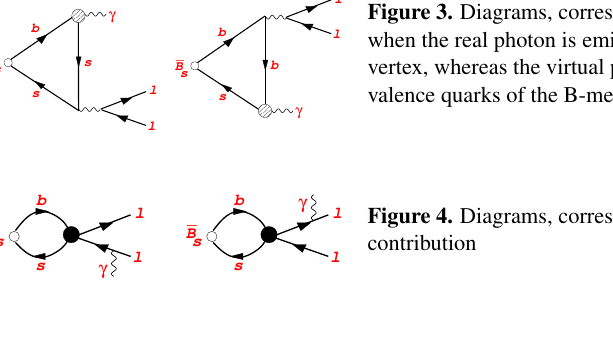
Figure 3. Diagrams, corresponding to the contribution when the real photon is emitted from the penguin FCNC